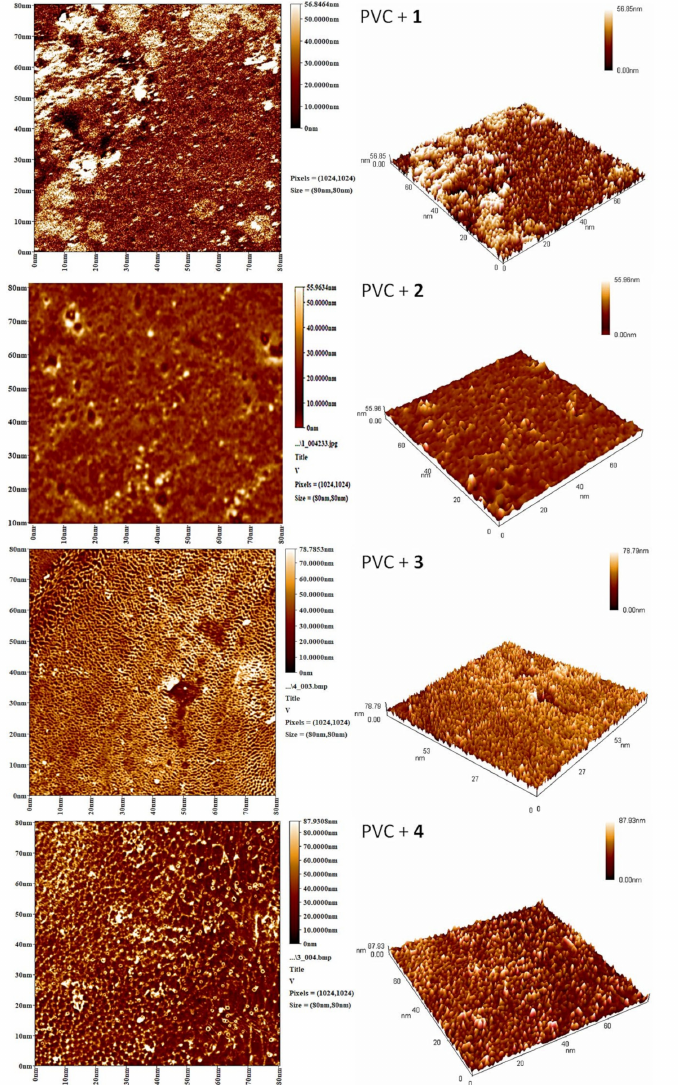
Figure 10. Atomic force microscopy (AFM) images showing the impact of irradiation on PVC–tin complex blends after